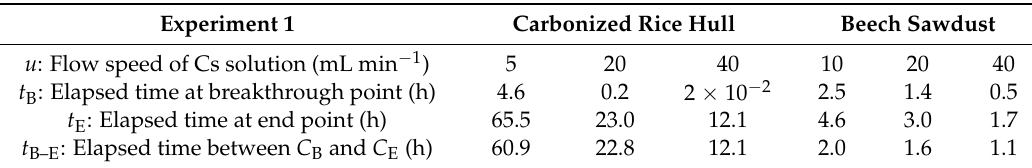
Table 3. Elapsed time at the breakthrough point and end point in experiment